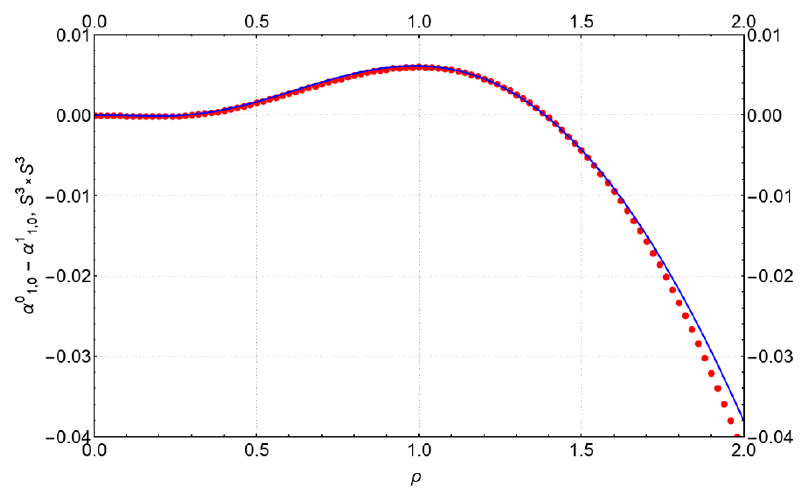
Figure 14 . A (cid:12)t of (cid:11) 0